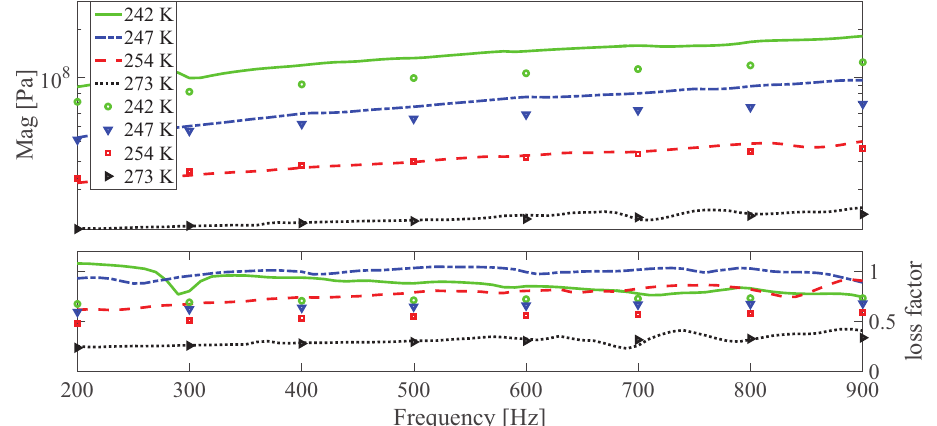
Figure 13. The magnitude and loss factor of the dynamic shear modulus versus frequency at 0.0015 strain amplitude and 0.55T under different temperatures. Lines and symbols are the simulation and measurement results, respectively.